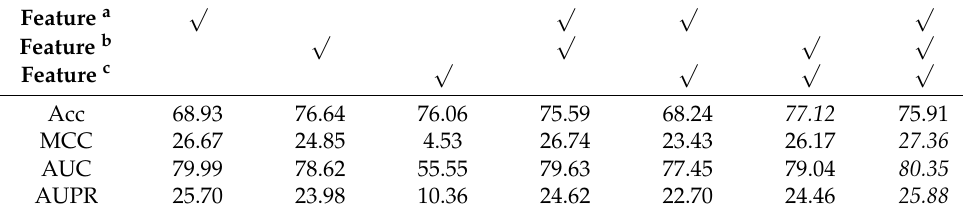
Table 4. The 10-fold cross-validation performance with different single features or feature combina- tions (the data are percentages). The highest value in each category is shown in italic.